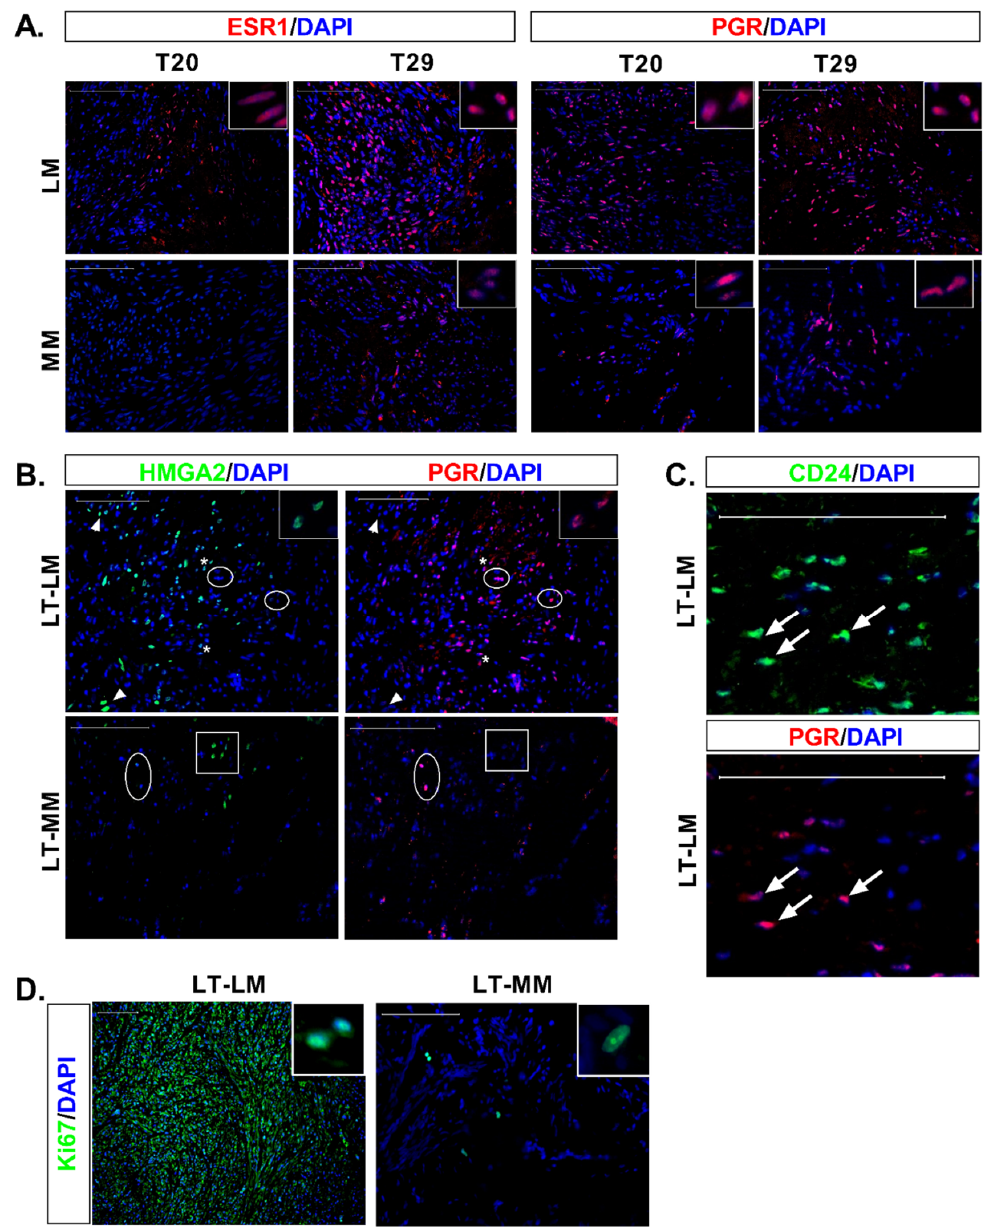
Figure 3. Expression of the ovarian hormone receptors, colocalization of progesterone receptor with HMGA2 and CD24 and expression of Ki67 proliferation marker in long-term culture. ( A ) IF staining of tissue sections with ESR1 (red) and PGR (red), shows more immunoreactive cells at T29 than T20 in LM and MM. A higher number of immunoreactive cells were detected in LM than MM at both time points and for both receptors. ( B ) Colocalization of HMGA2 (green) and PGR (red) in LM at long-term culture (LT). A high HMGA2 signal was detected in cells not expressing PGR (arrowheads), while cells expressing high levels of PGR lacked HMGA2 expression (circle). In cells with weaker expression of HMGA2 and PGR, colocalization between both markers was detected (asterisk, with a detailed view in the insert). In myometrium (MM), cells expressing HMGA2 at variable degree (square) did not express PGR. Similarly, cells expressing PGR (circle), did not express HMGA2. ( C ) Strong colocalization of CD24 (green) with PGR (red) was detected in LM cells (arrow) after long-term culture. ( D ) Almost all cells in the LM slice were Ki-67 + , whereas few cells were immunostained in MM. The inserts (top right) show a detail of the cell nucleus in both tissues Nuclei were counterstained with DAPI (blue). Scale bar, 100 µ